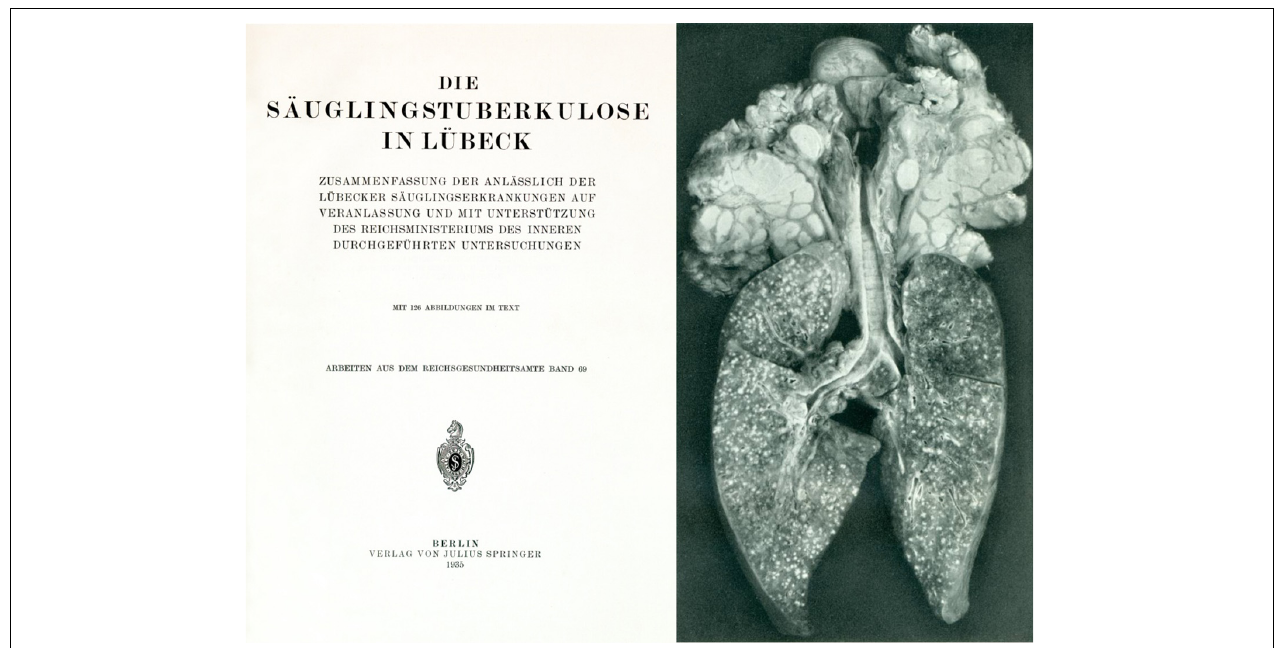
FIGURE 5 | Title page of the report on investigations into the so-called Lubeck disaster and photo from this report depicting lung and lymph nodes with numerous lesions caused by M. tuberculosis contamination of BCG (Moegling,